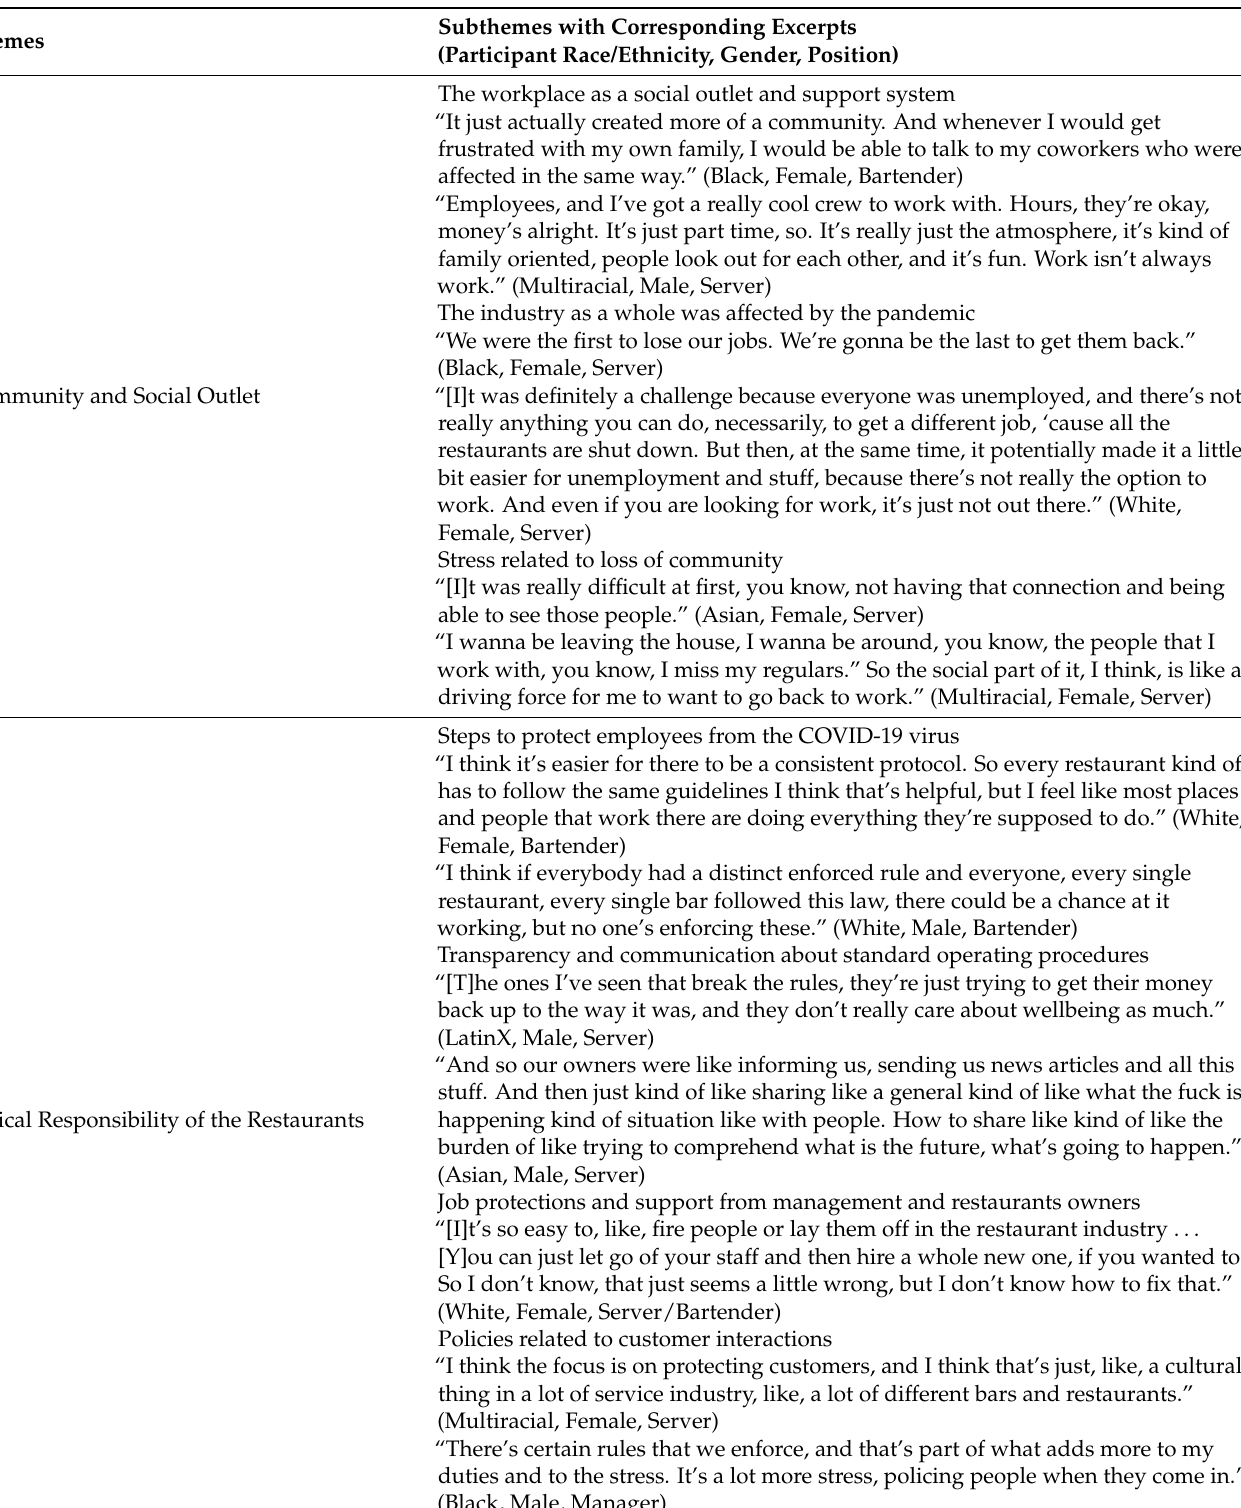
Table 2. Summary of themes generated from semi-structured